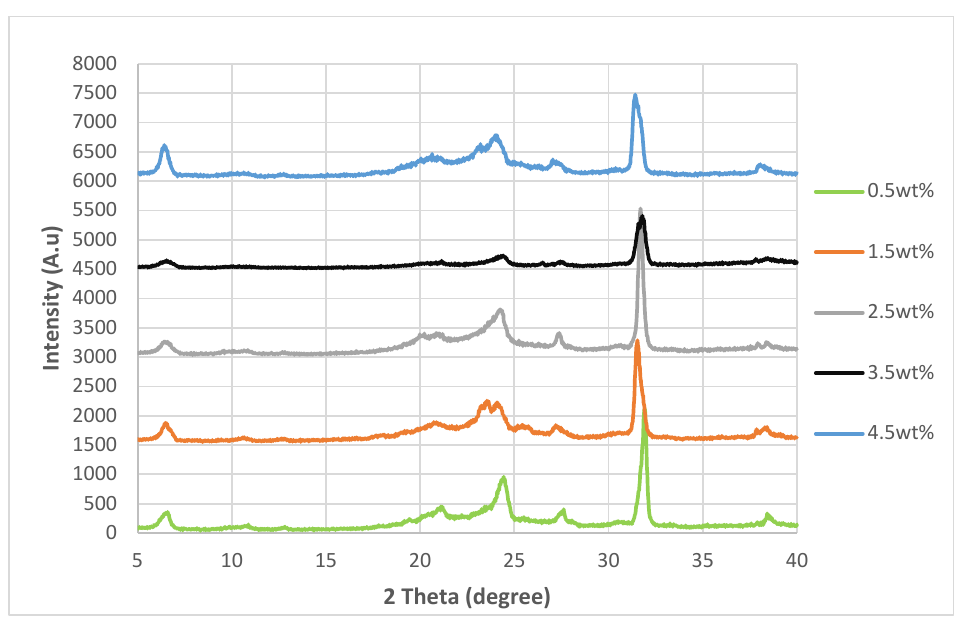
Figure 6. XRD Spectra of Nylon 610 Nanocomposites with Graphite Nanosheets Treated at 150 °C and − 0.1 MPa.